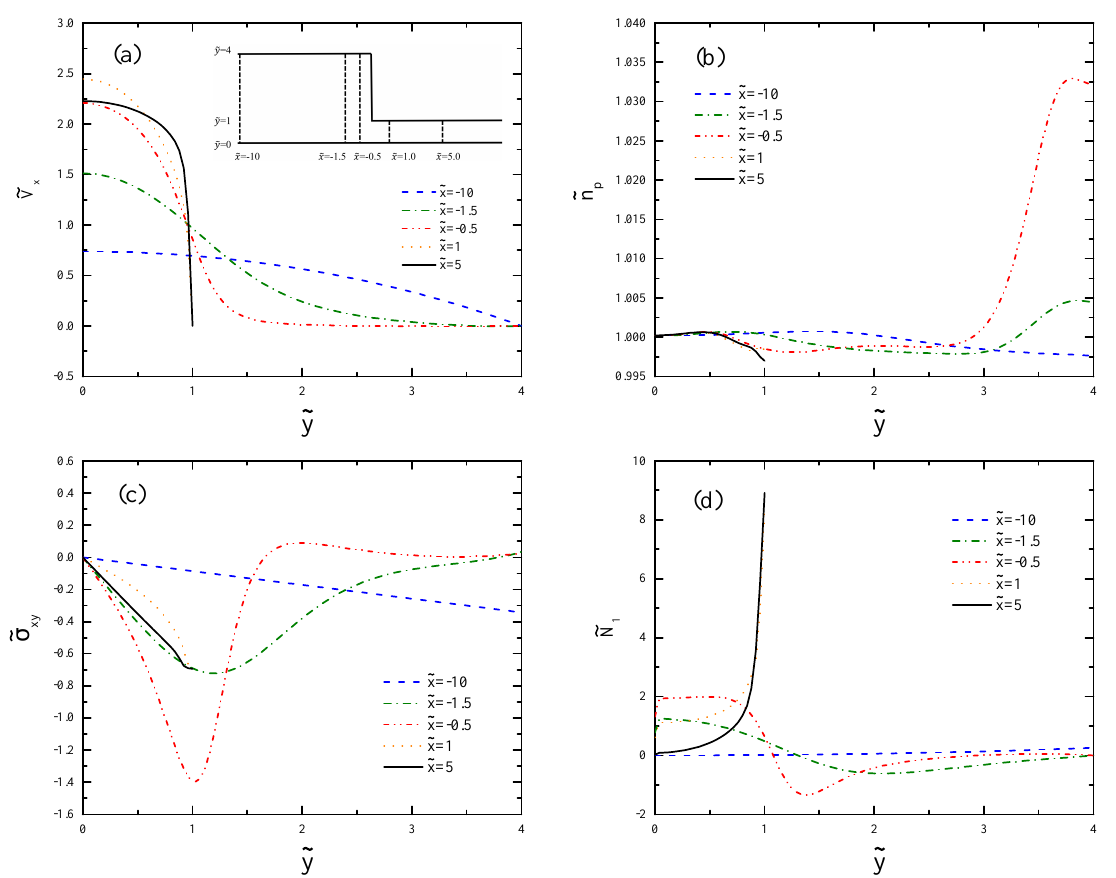
Figure 11. Cross-sectional profiles of ( a ) axial velocity, ( b ) polymer number density, ( c ) shear stress, and ( d ) first normal stress difference for De = 2.0. The selected ˜x-values are the same as in Figure